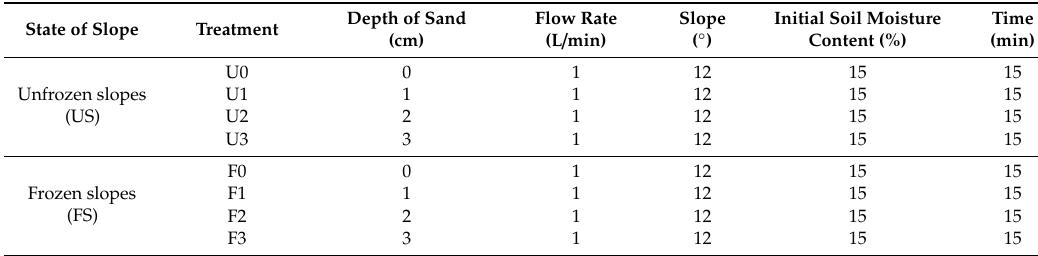
Table 1. Design table of scour